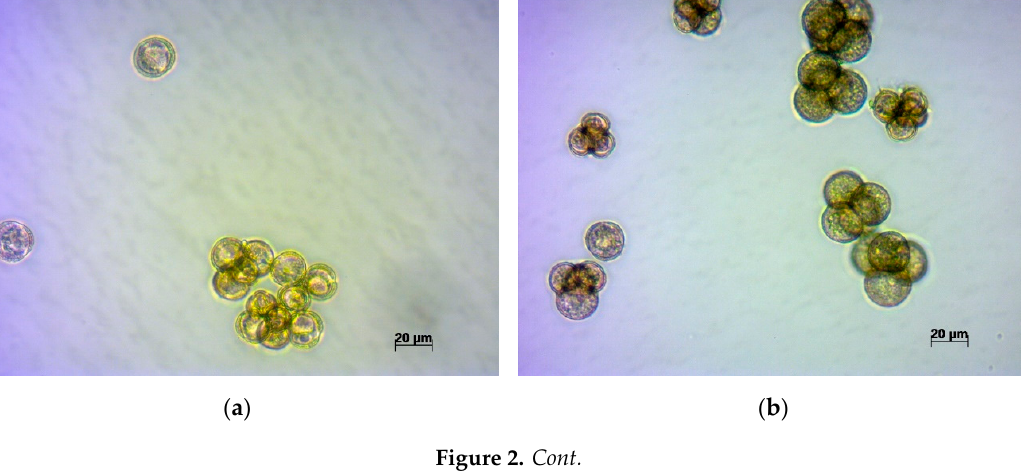
( e ) Figure 2. Development of microspores of turnip variety ‘Ronde witte roodkop herfst’ in the in vitro culture: ( a ) Microspores at the beginning of incubation; ( b ) microspores at day 3 of incubation; ( c ) development of microspores at day 7 of incubation; ( d ) turnip embryo developed from microspores, day 14 of incubation; and ( e ) fused turnip embryos developed from microspores (possibly non- separated ones), day 21 of incubation. 2.4. A Study on Microspore Development in the In Vitro Culture The development of turnip microspores into embryos occurred either by direct embryo formation, or by a suspensor-like structure formation (Figure 3). The embryos that formed from